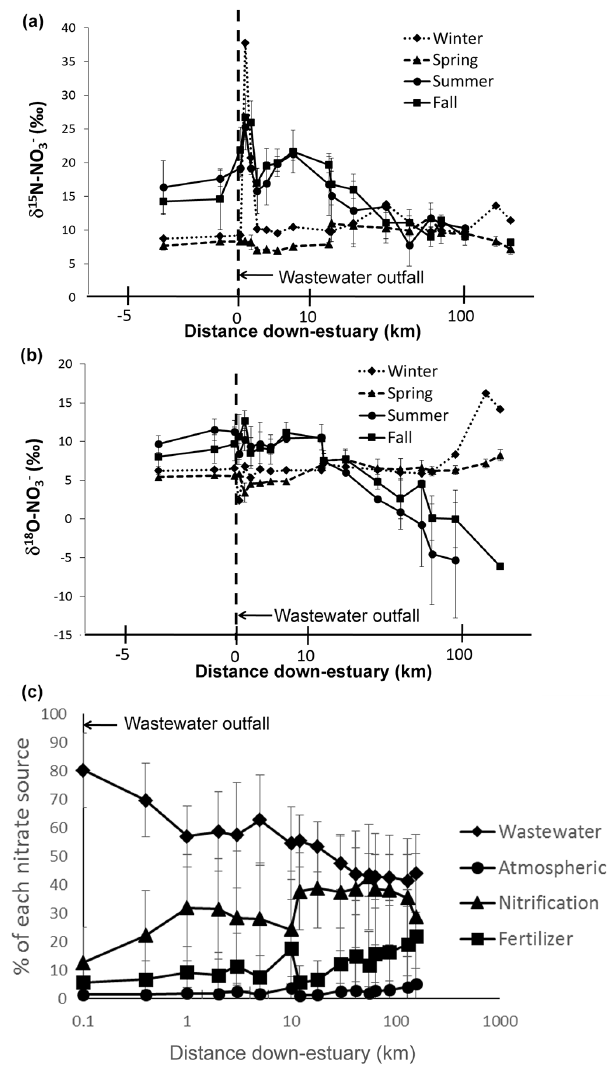
Figure 5. Trends in (a) δ 15 N-NO − , (b) δ 18 O-NO − , and (c) percent 3 3 contribution of nitrate from wastewater, fertilizer, atmospheric de- position, and nitrification, based on the isotope mixing model, with distance down-estuary from wastewater treatment plant input. Error bars are standard errors of the mean. N = 1 for winter, N = 3 for spring and fall, and N = 2 for summer.